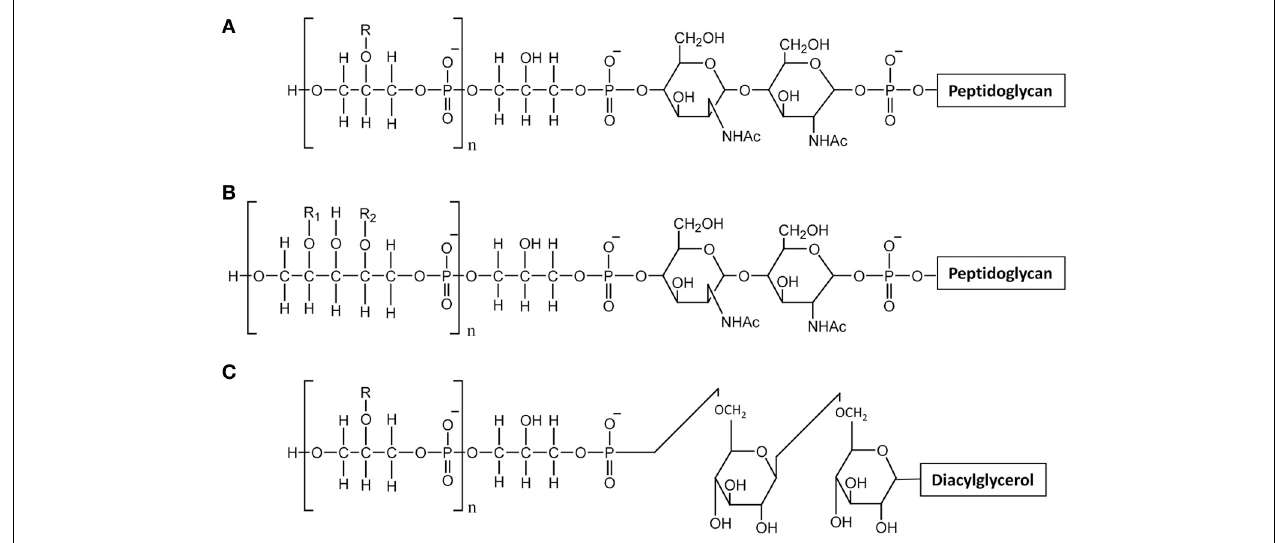
FIGURE 3 | Structure of teichoic acids. (A) WTA with poly-glycerol-phosphate chains; (B) WTA with poly-ribitol-phosphate chain; (C) LTA with poly-glycerol-phosphate chains. R, R1, R2 indicate potential substituent groups of polyols chains (e.g., D-Ala, Glc, Gal, GlcNAc).